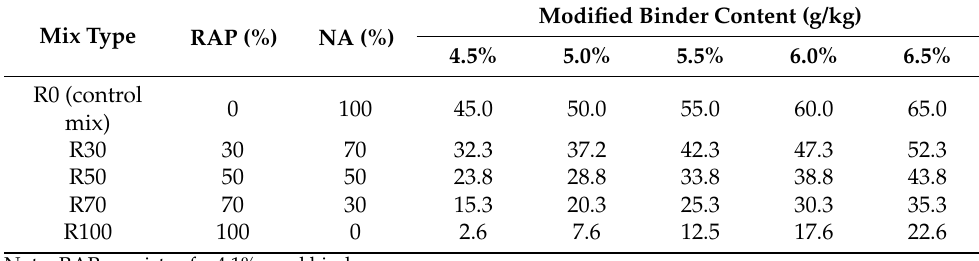
Table 3. The composition of each